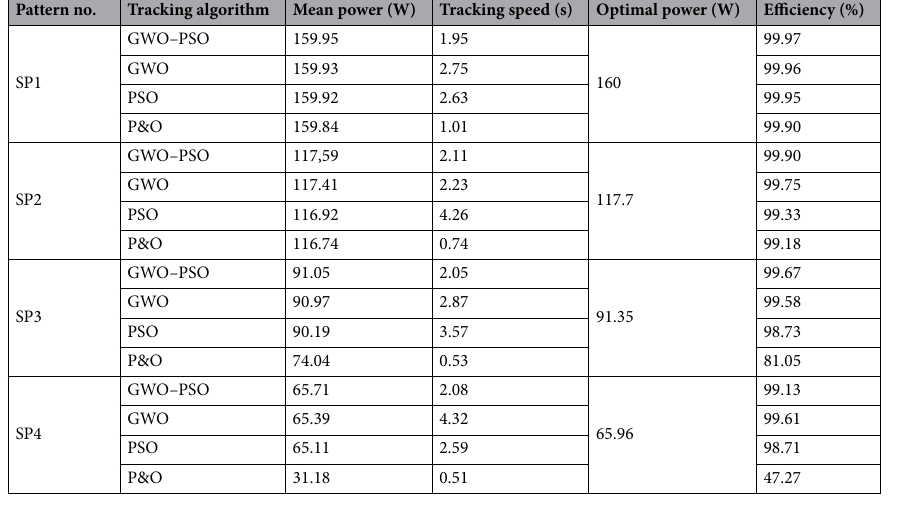
Table 4. Comparison between the GWO–PSO, gwo, pso and p&o based mppt methods under different shading patterns.